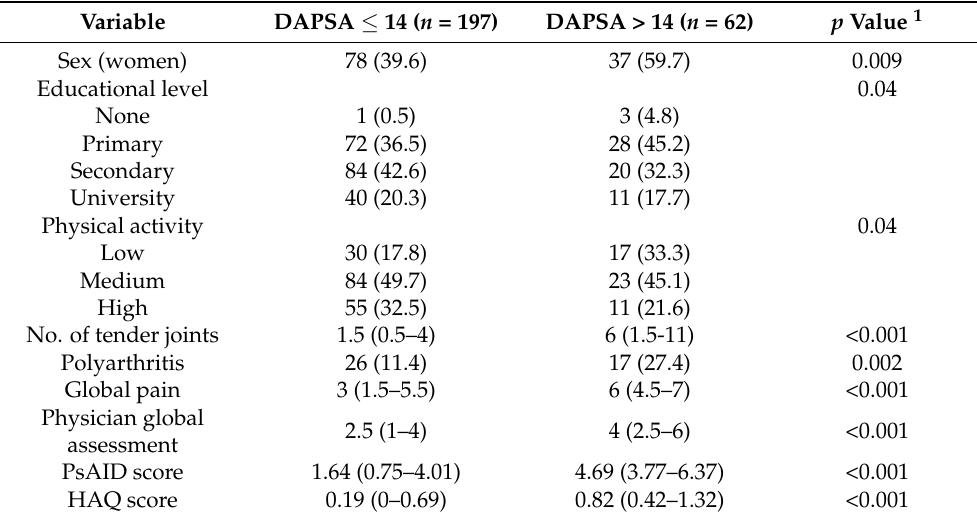
Table 1. Variables associated with moderate-high activity (DAPSA > 14): Bivariate